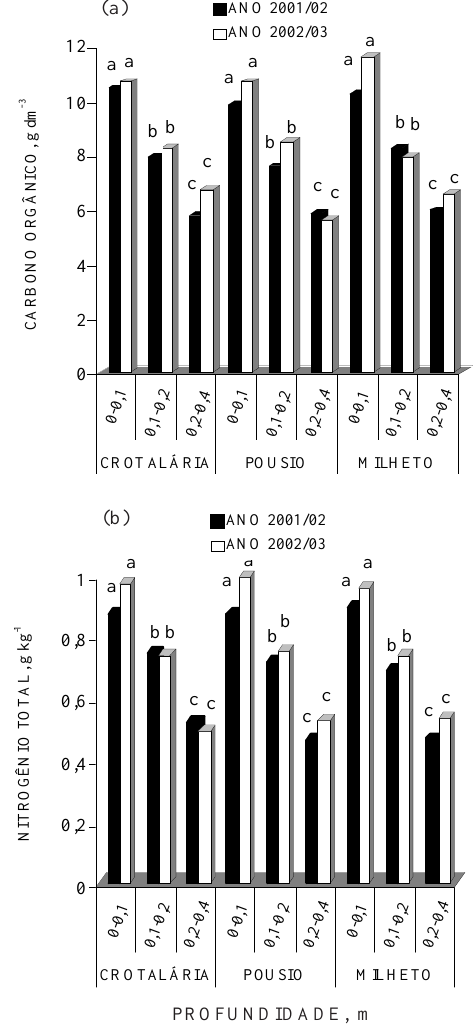
Figura 1. Teores de carbono orgânico (a) e de N total (b) no solo, nas camadas de 0–0,10; 0,10–0,20 e 0,20–0,40 m, na época do florescimento do milho cultivado em sucessão à crotalária, milheto e ao solo em pousio, anos agrícolas 2001/02 e 2002/03. (Obs. médias seguidas por letras distintas na coluna diferem entre si pelo teste de Tukey a 5